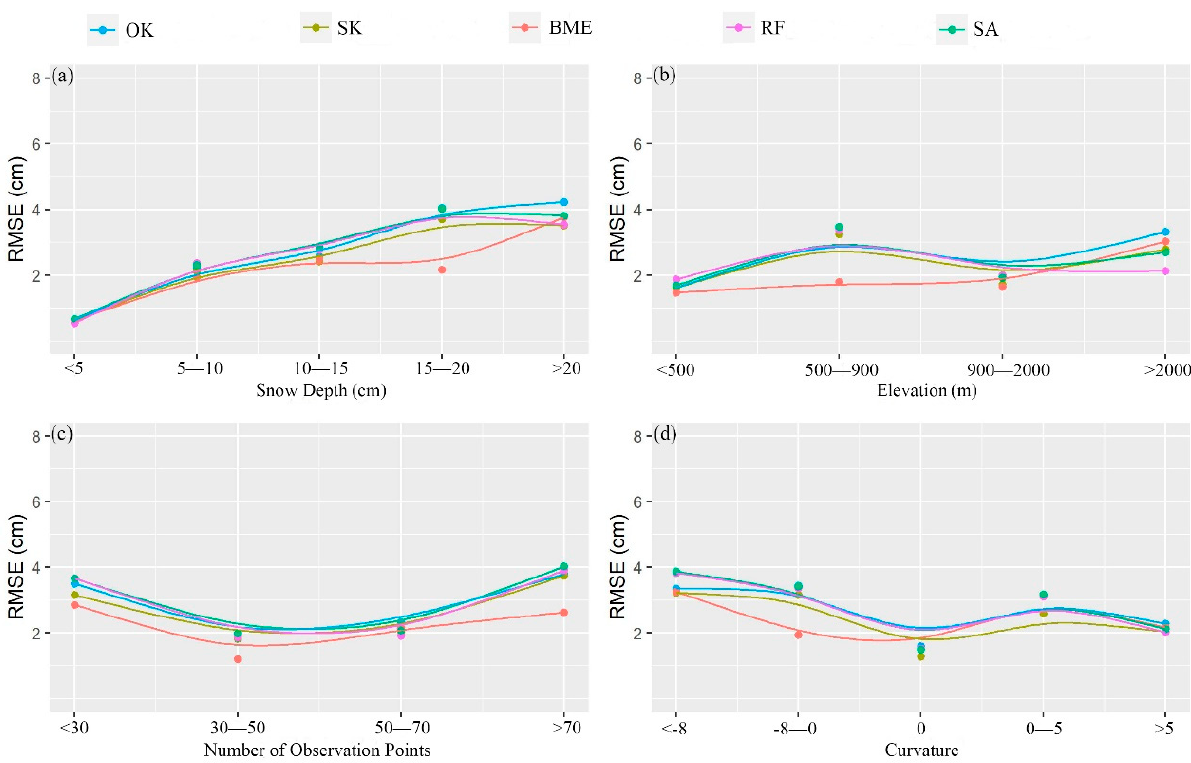
Figure 5. ( a – d ) Upscaling results of 500 m 2 snow plots in different scenarios.